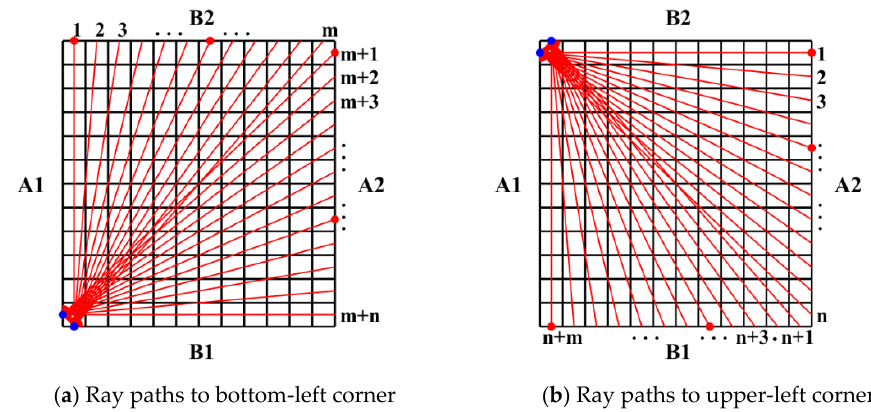
Figure 3. Scheme of grids division and data acquisition ( : Laser position, : Sensor). Table 1. Material properties of the aluminum plate.